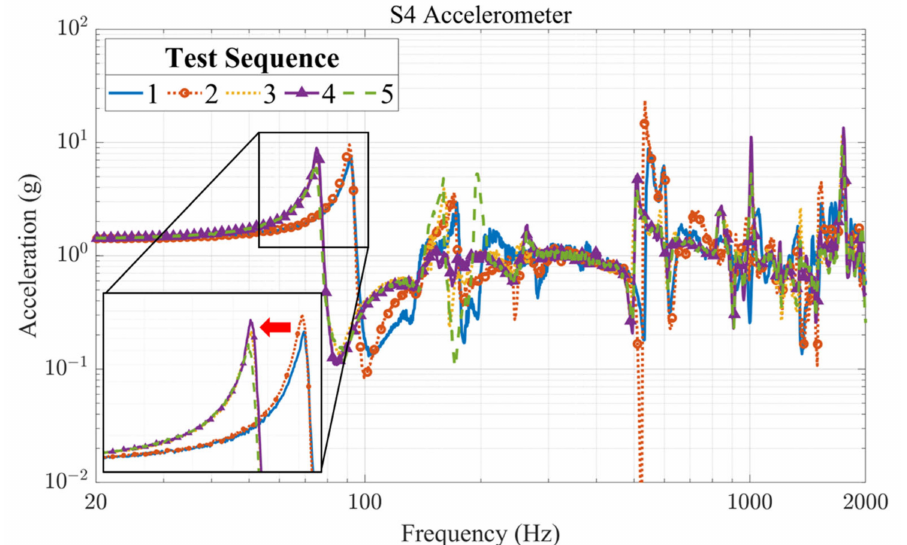
Figure 18. Change in natural frequency along the X-axis LLSS test as test